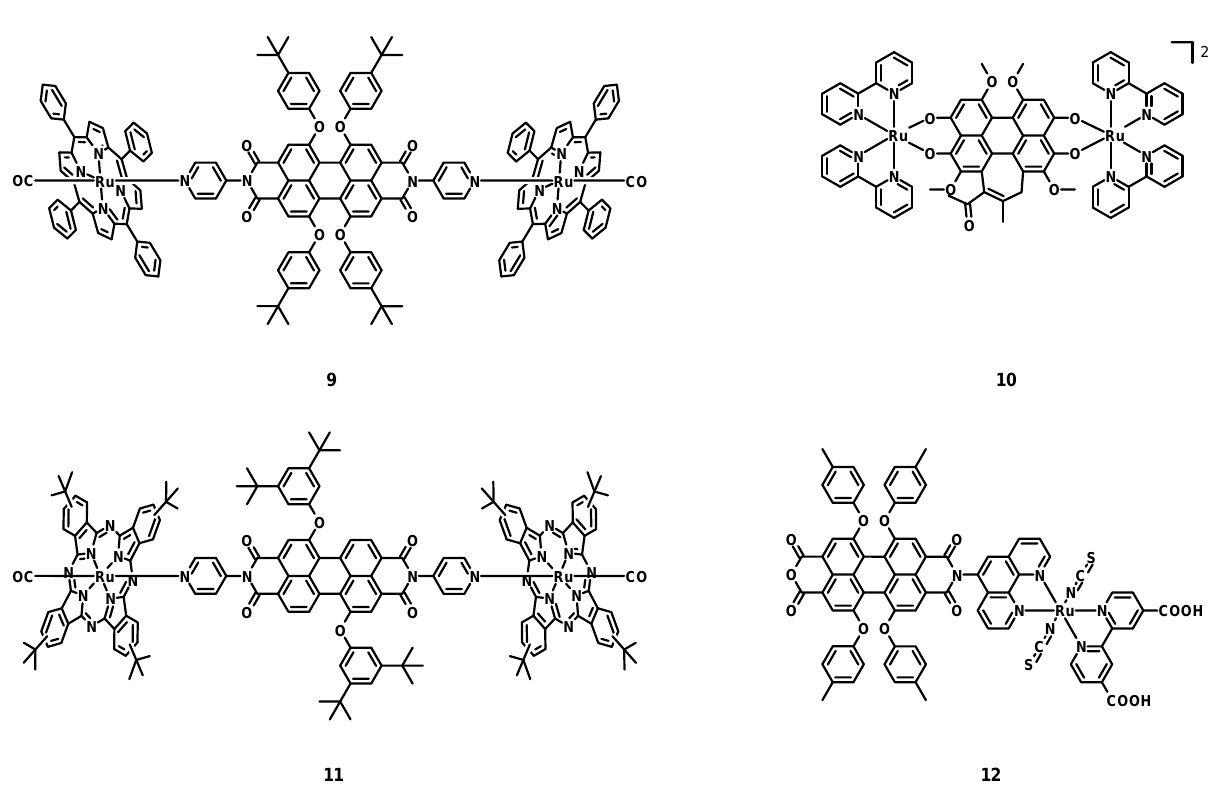
Figure 5. Structures of complexes 9 , 10 , 11 , and 12 . Table 2. Photophysical and redox properties of complexes 9 , 10 , 11 , 12 , 13a – d , 14a – e , 15a – c , and 16 . Complex reduction steps at − 0.62 and − 0.77 V vs. SCE and an irreversible oxidation at +1.6 V